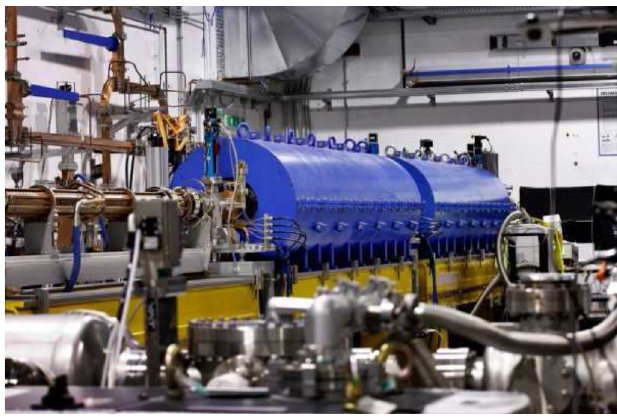
FIG. 2. SPARC linac accelerator provides a final maximum beam energy of about 178 MeV. The first two linac accelerating structures are surrounded by two long solenoids (blue structures) providing the additional focusing (with a maximum field of 0.18 T) required to match the beam envelope to the linac, according to the invariant envelope conditions, when the linac operates in velocity bunching compression mode.